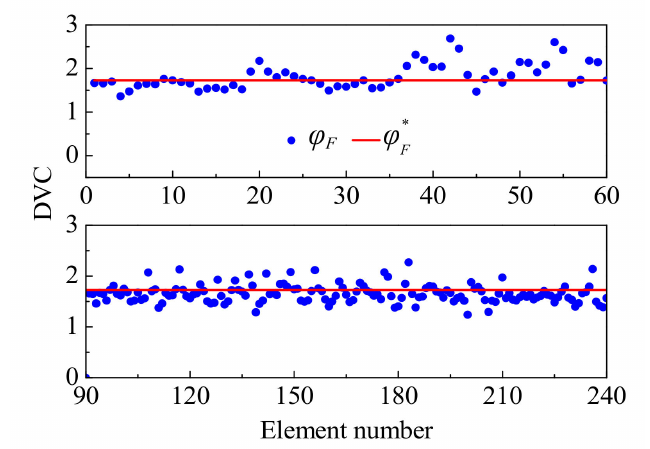
Figure 9. Comparison of the DVC of elemental internal force and the global DVC of internal